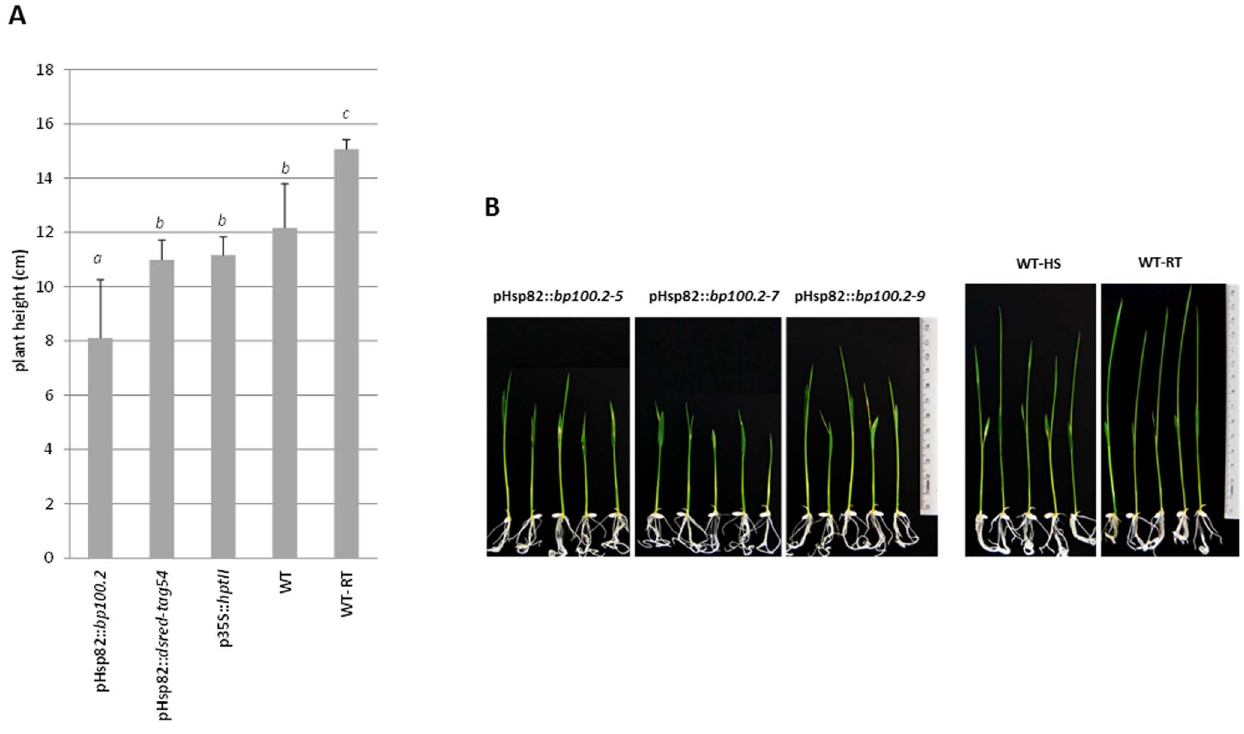
Figure 6. Growth of transgenic rice plants carrying pHsp82:: bp100.2 after heat shock. T 1 seeds of rice plants carrying pHsp82:: bp100.2 , pHsp82:: dsred-tag54 (three independent events per construct) and p35S:: hptII were germinated for 1 day in the presence of hygromycin, and five plants per event were then in vitro cultured, without the selection agent, up to the V2 stage (height, 6 6 1 cm). Five untransformed Senia plants were grown in parallel (WT). They were all treated at 42 u C for 2 h and the length of their aerial parts was measured after 24 h incubation under standard conditions. Five untransformed plants were not subjected to heat stress, as an additional control (WT-RT). ( A ) Means and SD of the height of the different groups are shown. Letters indicate statistically significant differences (One-way ANOVA, Tukey b posttest with a value , 0.05). ( B ) The phenotypic effects of heat treatment on transgenic plants carrying pHsp82:: bp100.2 (three independent events) and untransformed plants (WT-HS) are shown. WT-RT is shown as